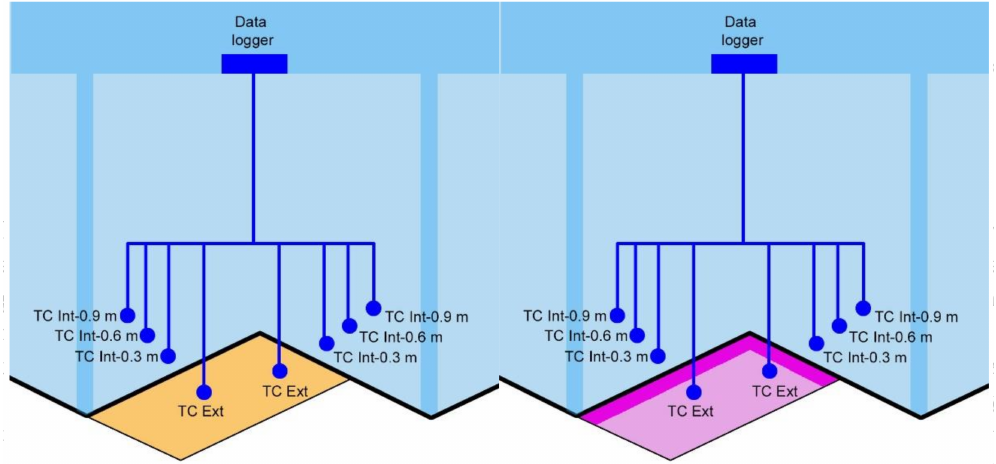
Figure 5. Detail of the experimental setup for balcony pair #5 and #6. The conventional balcony is shown on the left and the thermally-broken balcony is shown on the right (this particular balcony is thermally-broken in two places). TC = thermocouple; Int = interior; Ext =